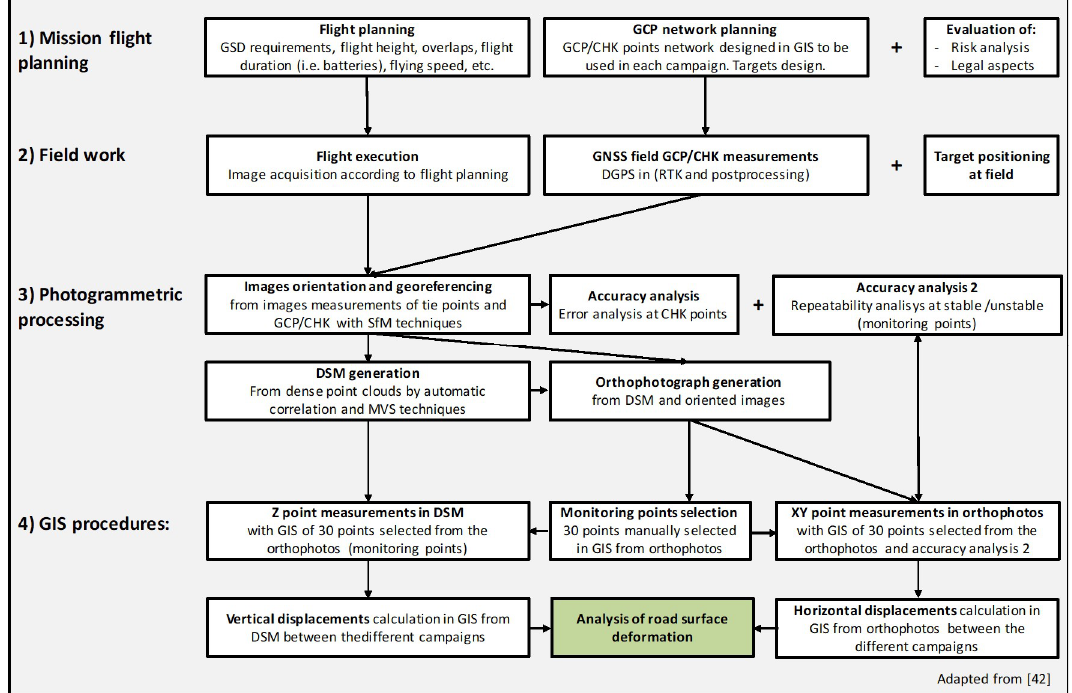
Figure 3. Methodology flow chart.